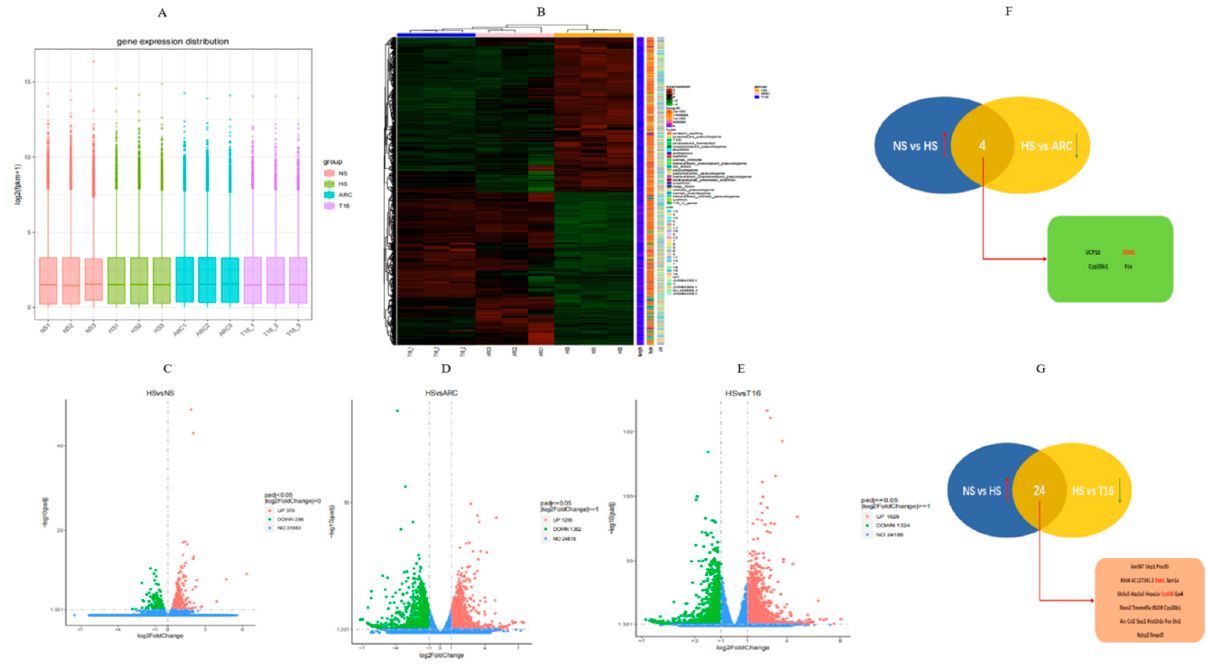
Figure 5. ( A ) FPKM box plot of the expression levels of transcripts in each group. ( B ) Heatmap clustering analyses of differential expression genes in each sample; obvious green color represents low gene expression, while red represents high expression. ( C – E ) Volcano plots showing differential expression genes between each group with different increased genes colored in red decreased genes colored in green and non-differential genes colored in blue. ( F , G ) Common differential expression genes are identified in Venn diagrams between these upregulated genes with logFC > 1 in the HS